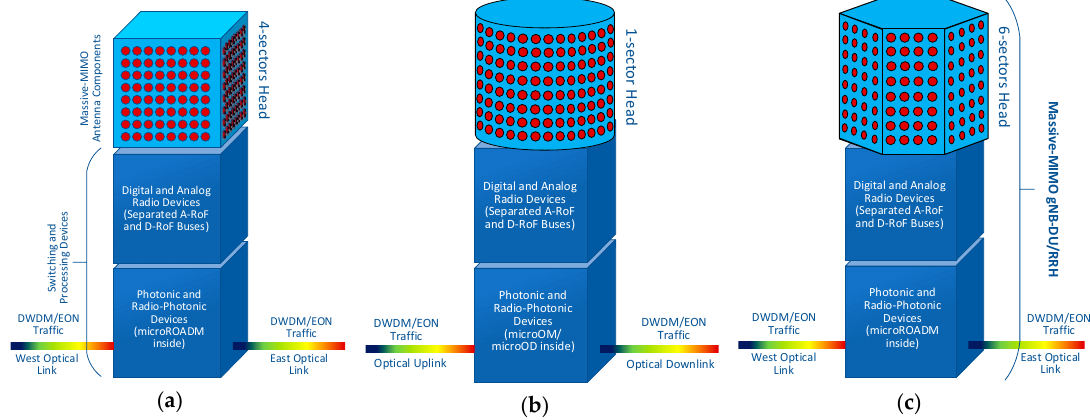
Figure 2. Block configurations of integrated massive-MIMO optical gNB-DUs / RRHs with the same photonic and radio-photonic modules (devices): ( a ) 4-sectors gNB-DU / RRH containing microROADM; ( b ) 1-sector gNB-DU / RRH containing microOM / microOD; ( c ) 6-sectors gNB-DU / RRH containing microROADM (concept first time presented in proceedings [6]).